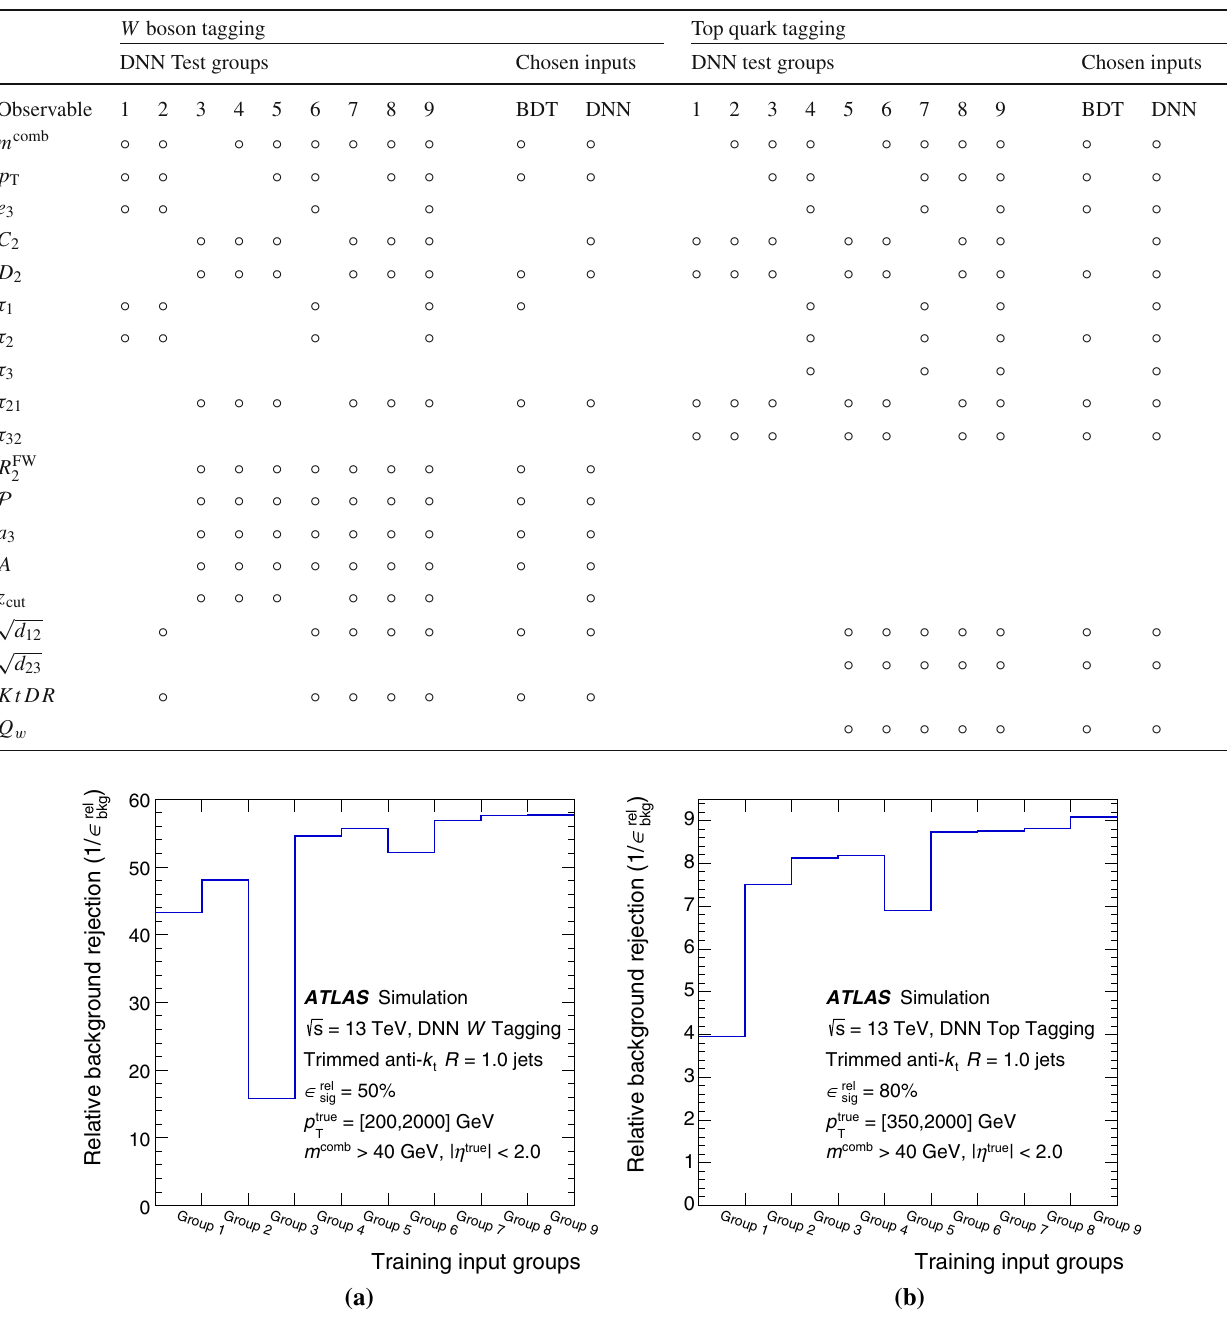
which satisfy the training criteria are considered when calculating the relative signal efficiency and relative background rejection. The perfor- mance is evaluated with constant p true spectra. Uncertainties are not T